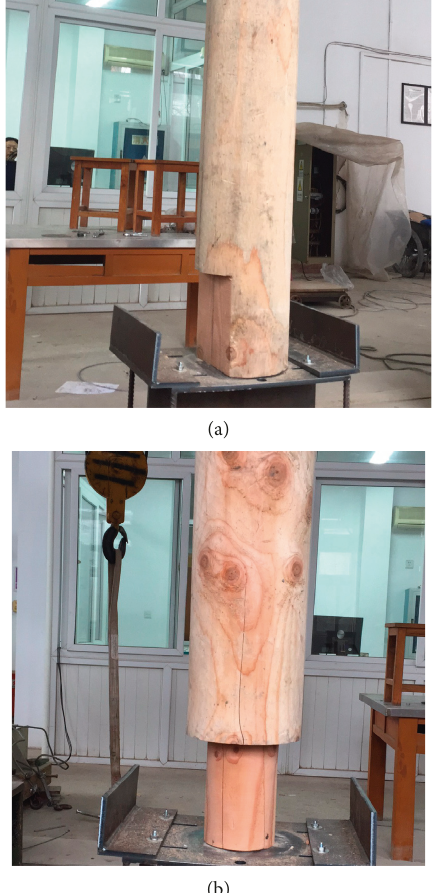
Figure 4: Models with artificial damage at the column foot. (a) Unilateral damage. (b) Circumferential damage.